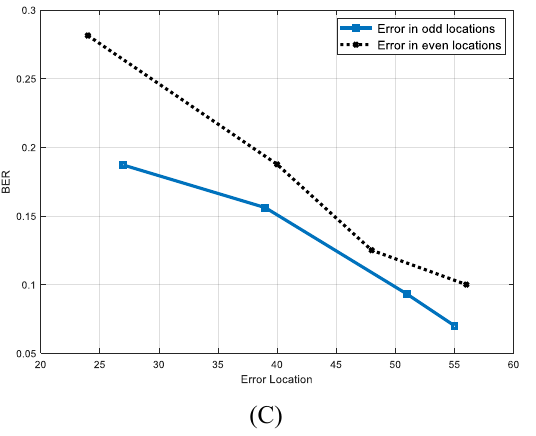
Figure 12 Single error propagation in SCL, 𝑅𝑎𝑡𝑒 = 0.5 , 𝑁 = 64